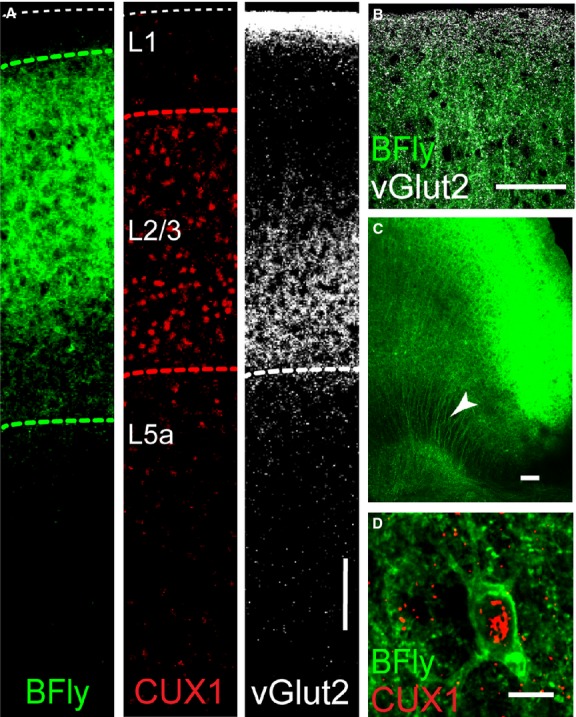
Butterfly VSFP2.1 is expressed in L2/3 pyramidal neurons of motor cortex from the Rasgrf2-2A-dCre;Camk2a-tTA;Ai78 (TITL-VSFPB) Butterfly mouse. (A) Layer specific Butterfly expression in the motor cortex evident within the boundaries occupied by L2/3 pyramidal neuron somas and dendrites, green dashed lines, L2/3 is defined by the presence of CUX1-expressing pyramidal neurons (red dashed lines) and its lower boundary with L5a defined by vGLUT2 expression (white dashed line, scale bar 100 μm). Butterfly expression in L2/3 pyramidal neuron apical dendrites among vGLUT2-positive terminals in L1, (B) L2/3 pyramidal neuron axon projections (arrowhead), (C) (scale bar 100 μm), and the somatic plasma membrane, (D) (scale bar 10 μm).